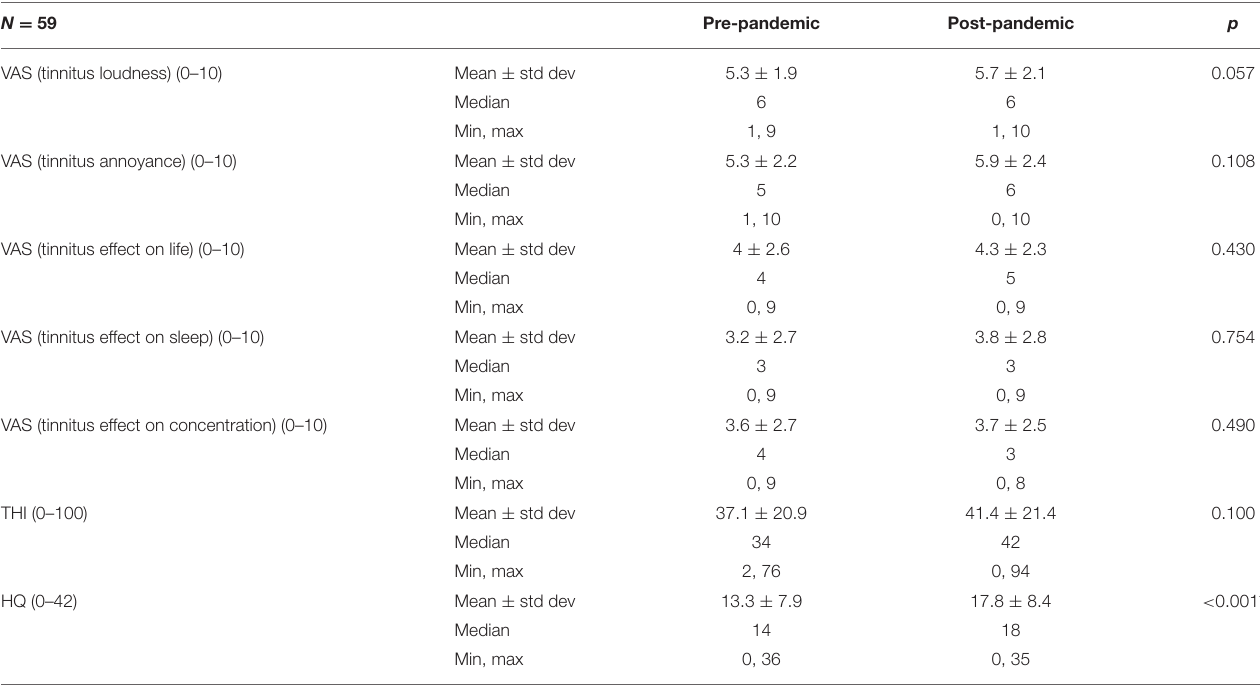
TABLE 3 | Scores of Tinnitus Handicap Inventory (THI), Hyperacusis Questionnaire (HQ), and the visual analog scales (VAS) in COVID-19-negative tinnitus patients. N = 59 Pre-pandemic